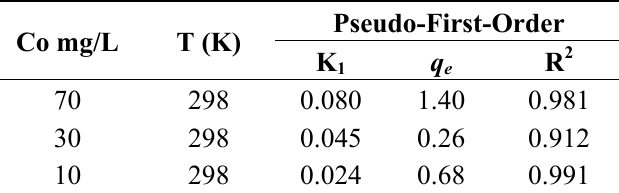
Table 1. Kinetic pseudo-first-order model parameters of the biosorption at various concentrations of composite beads.